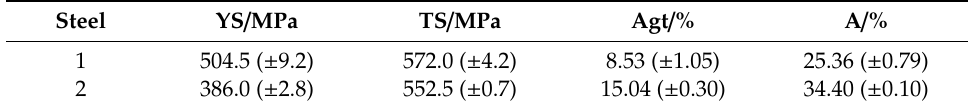
Table 2. Tensile properties of experimental steel.